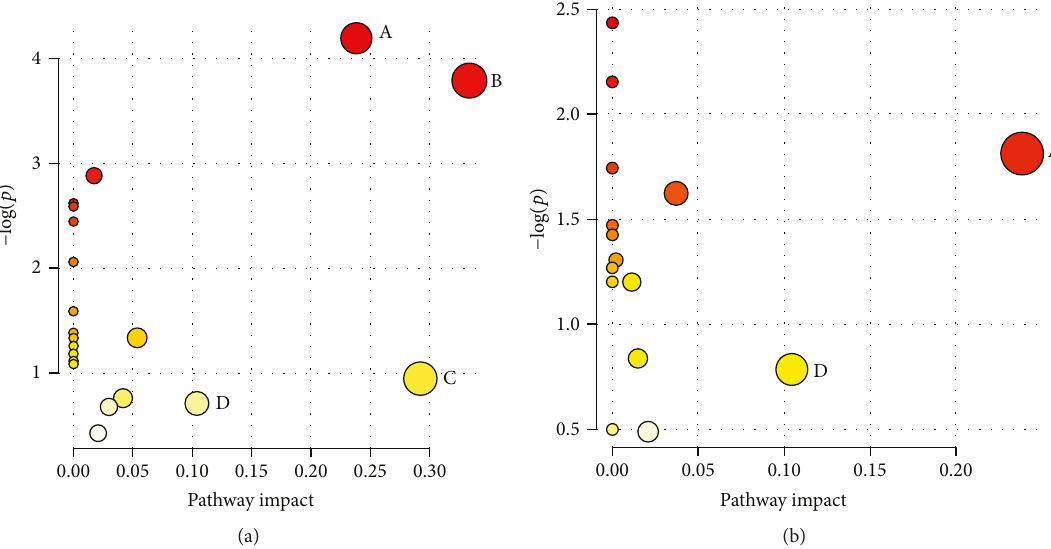
Figure 6: Summary of pathway analysis. (A) Nicotinate and nicotinamide metabolism, (B) glyoxylate and dicarboxylate metabolism, (C) glycine, serine, and threonine metabolism, and (D) arginine and proline metabolism.